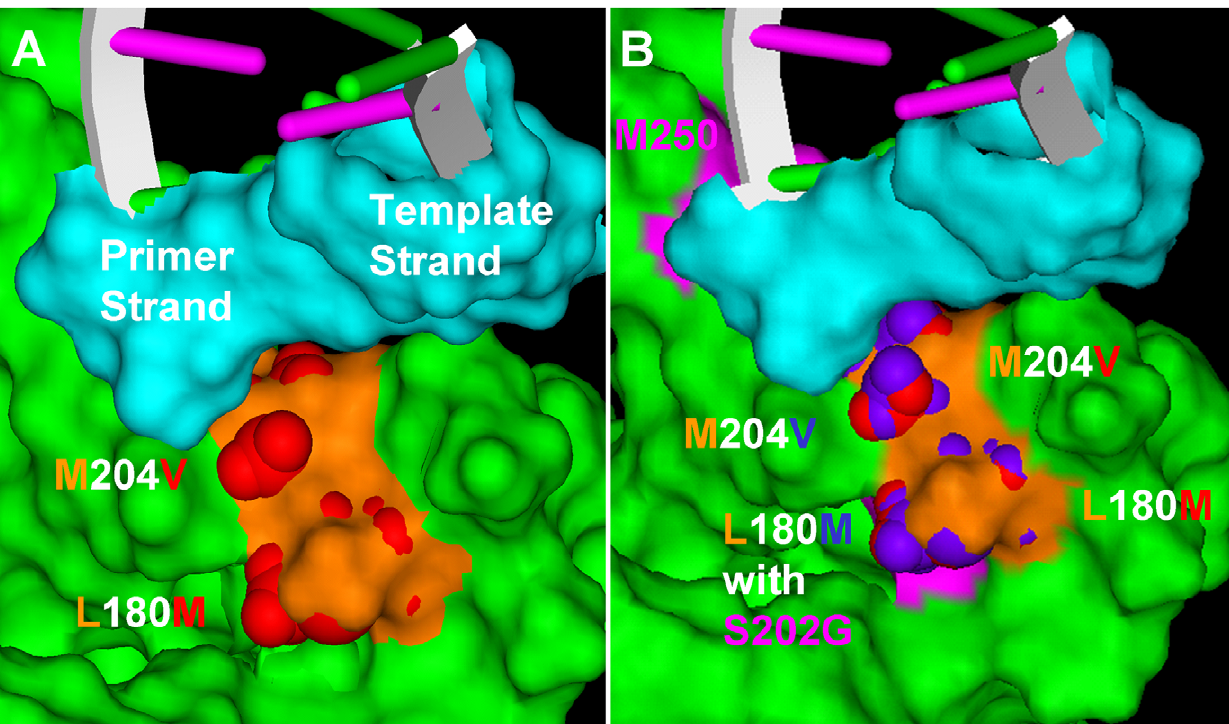
Figure 2. Molecular homology model of resistant HBV RTs. The ETV-TP binding pocket of HBV RT. [3]. (A) HBV RT with LVDr substitutions, M204V + L180M, (B) HBV RT with LVDr + S202G. HBV RT, ETV-TP and primer-template DNAs are labeled. The residues lining the pocket are orange, changes from LVDr are red, from ETVr are blue, and the M250, S202, and T184 residue positions (panel B) are pink. Panel A was essential reproduced from [3] with